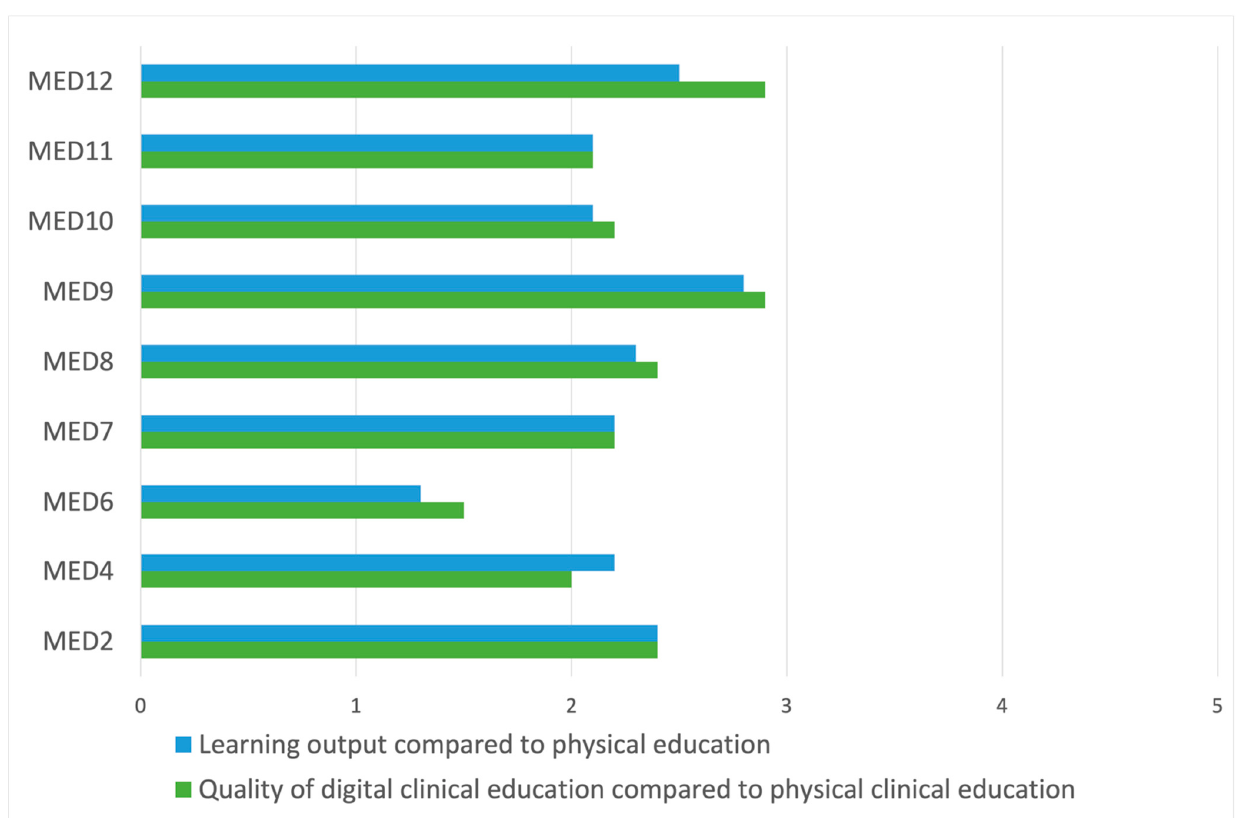
Figure 2. Distribution of agreement, disagreement, or neutral view on statements regarding clinical and practical education.